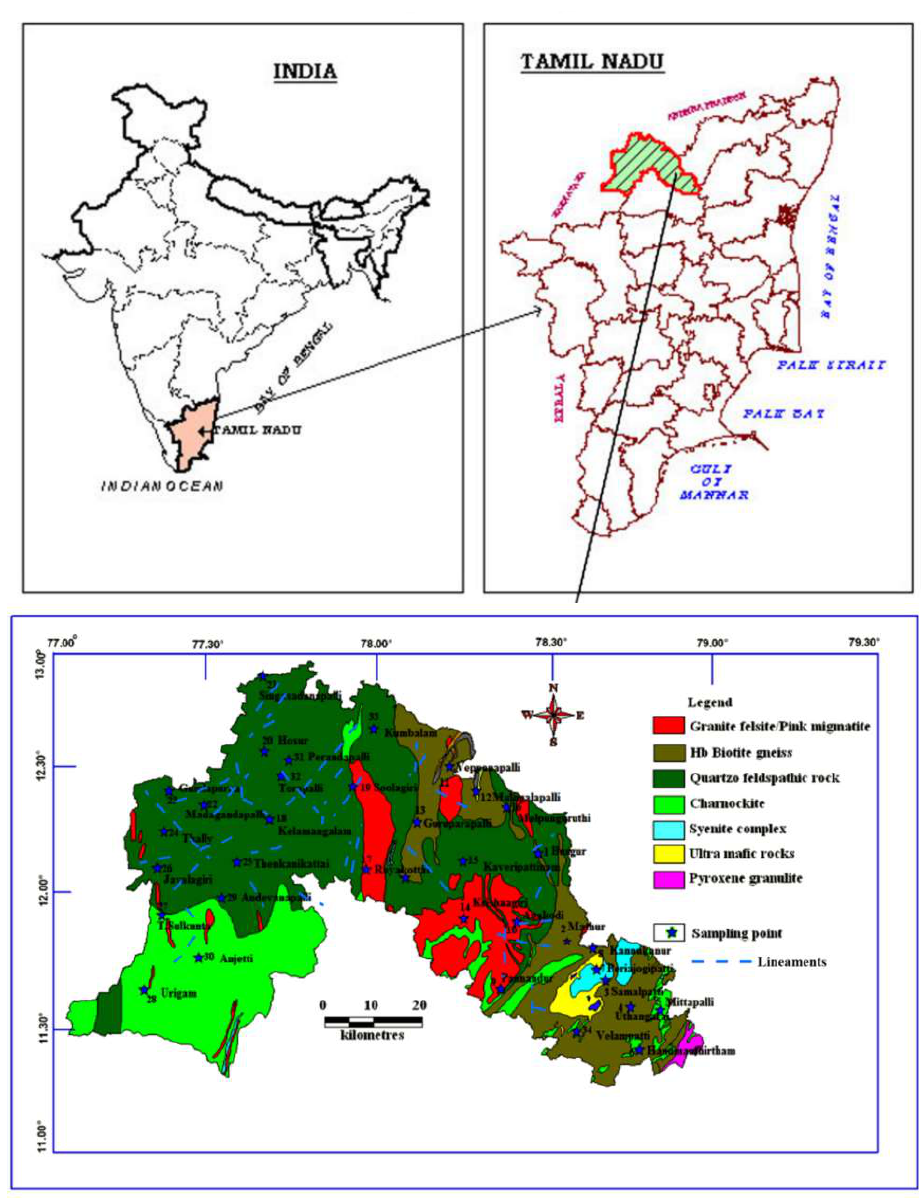
Figure 1. Geology and sample location map of the study area.